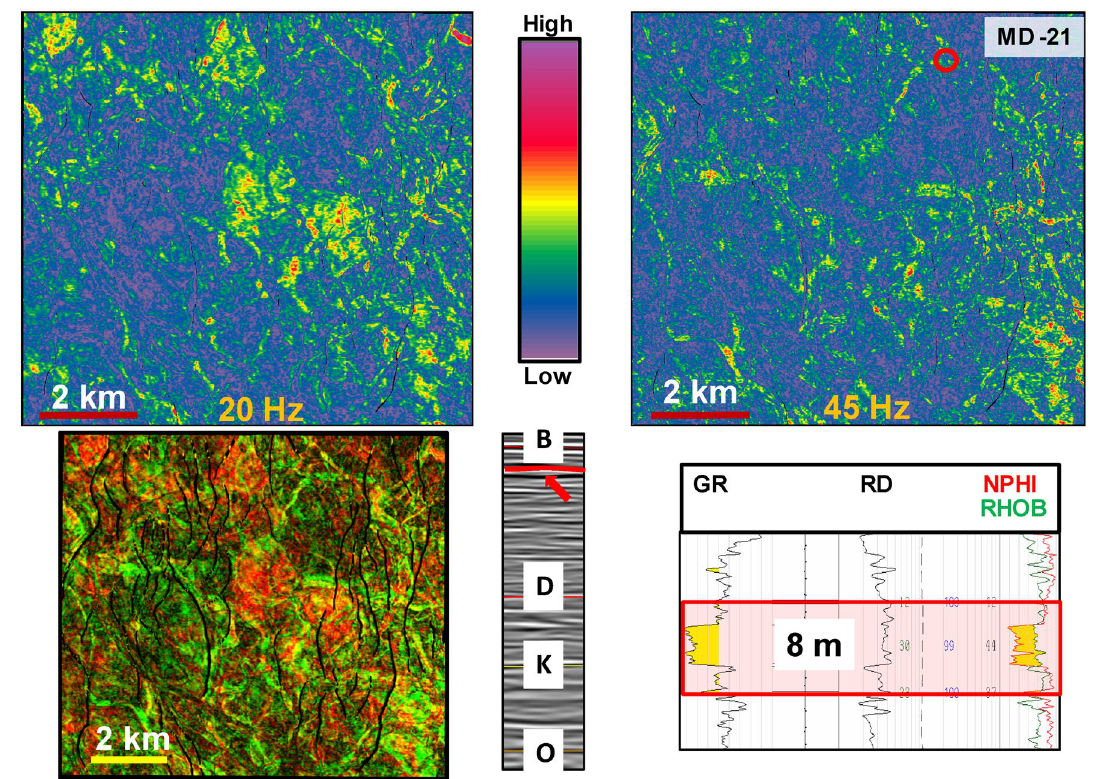
Fig. 11 Spectral decomposition CWT gives different responses at 20 Hz ( a ) and 45 Hz ( b ) at horizon slice B+80. Well location shows high amplitude at 45 Hz since the sand is thinner confirmed by well Fig. 12 RGB blending of 20 Hz, 35 Hz, and 45 Hz showing the presence of fluvial channels which were not visible in other horizon